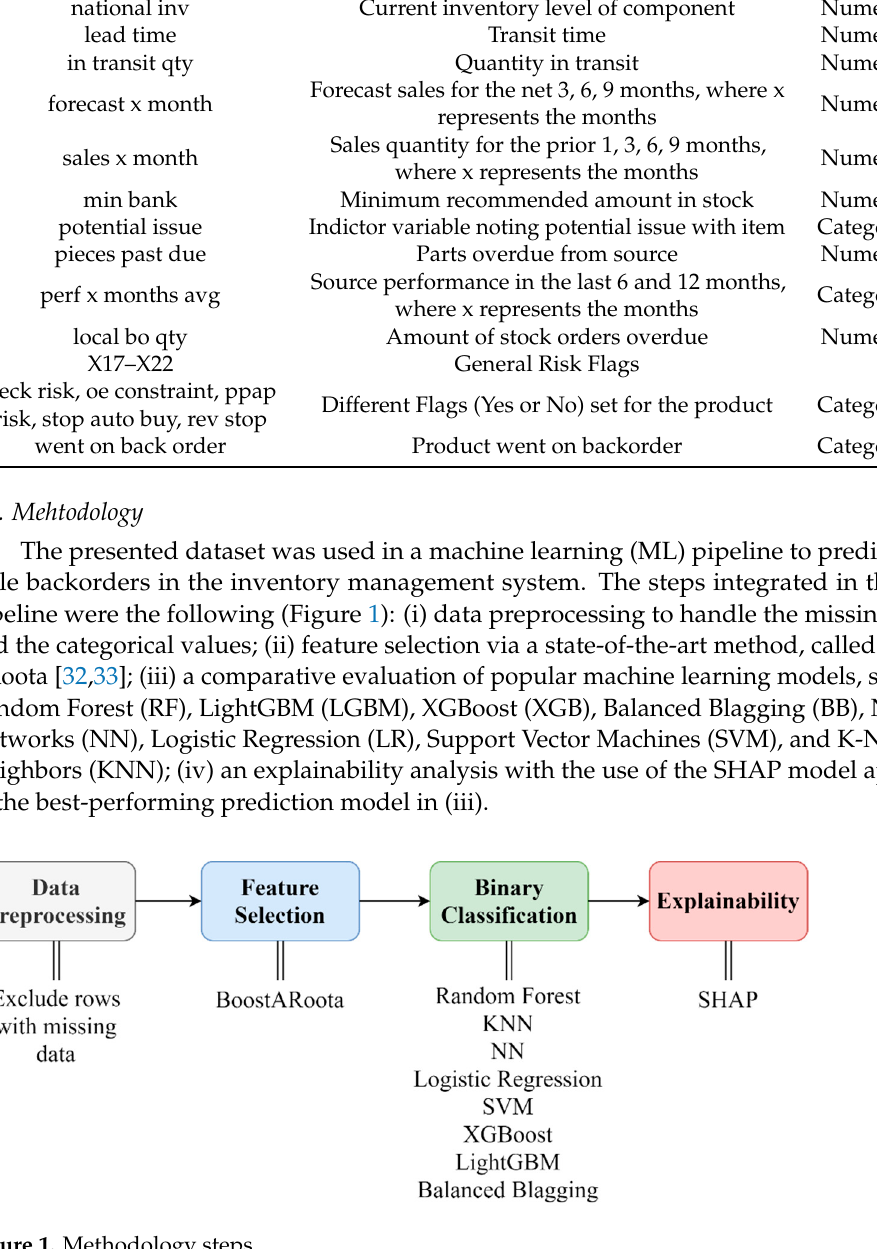
Table 1. Dataset description.